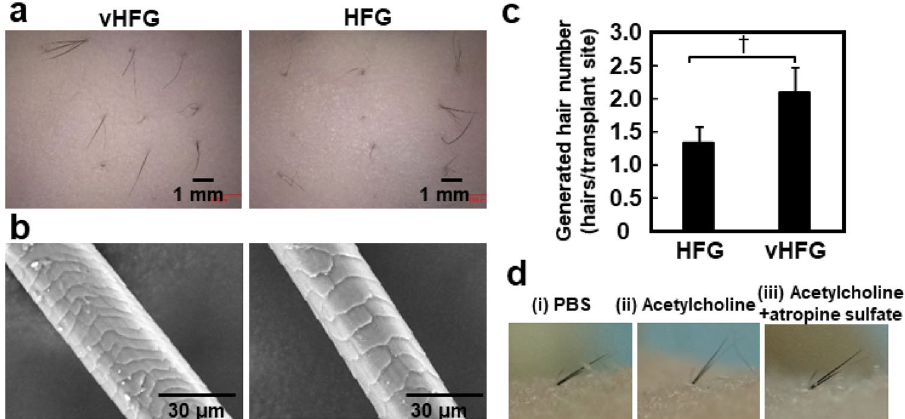
Figure 5. Intracutaneous transplantation of vHFGs and piloerection assay. ( a ) Hair shafts generated 3 weeks after transplantation of vHFGs and HFGs into the dorsal murine skin. ( b ) Scanning electron microscopic images of generated hair shafts. ( c ) Number of generated hair shafts. Values and error bars were calculated from at least 15 HFG transplantations for each condition in three independent experiments. Numerical variables were statistically evaluated using the Student’s t -test. p < 0.1 is represented by †. ( d ) Piloerection of generated hair shafts after injection of (i) PBS, (ii) acetylcholine, and (iii) acetylcholine plus atropine